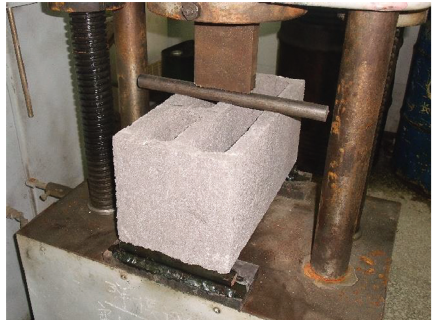
Figure 6: Specimen of the loading device. Table 5: Comparison of recycled concrete blocks with other